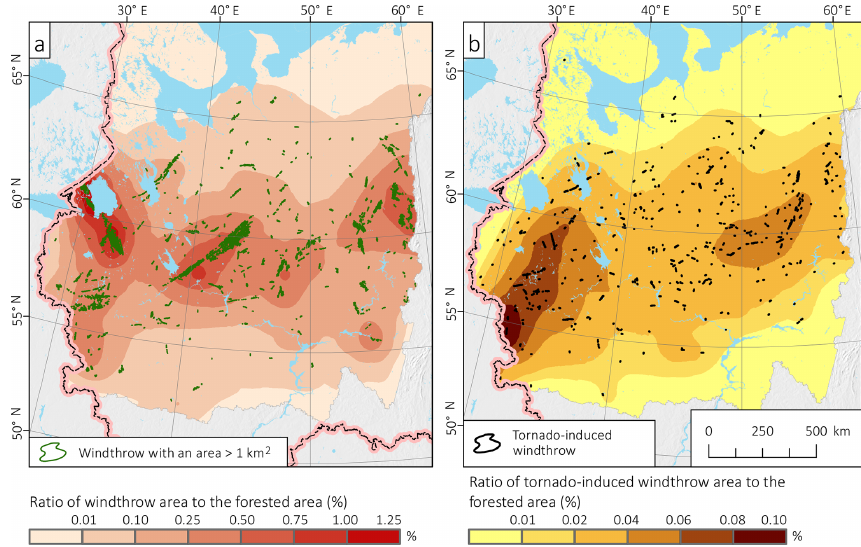
Figure 11. Ratio of damaged area to the forest-covered area for (a) all windthrow and (b) tornado-induced windthrow only. The ratio of windthrow area to the forest-covered area was calculated for a 100km 2 cell and then interpolated with the local polynomial interpolation method from ArcGis Geostatistical